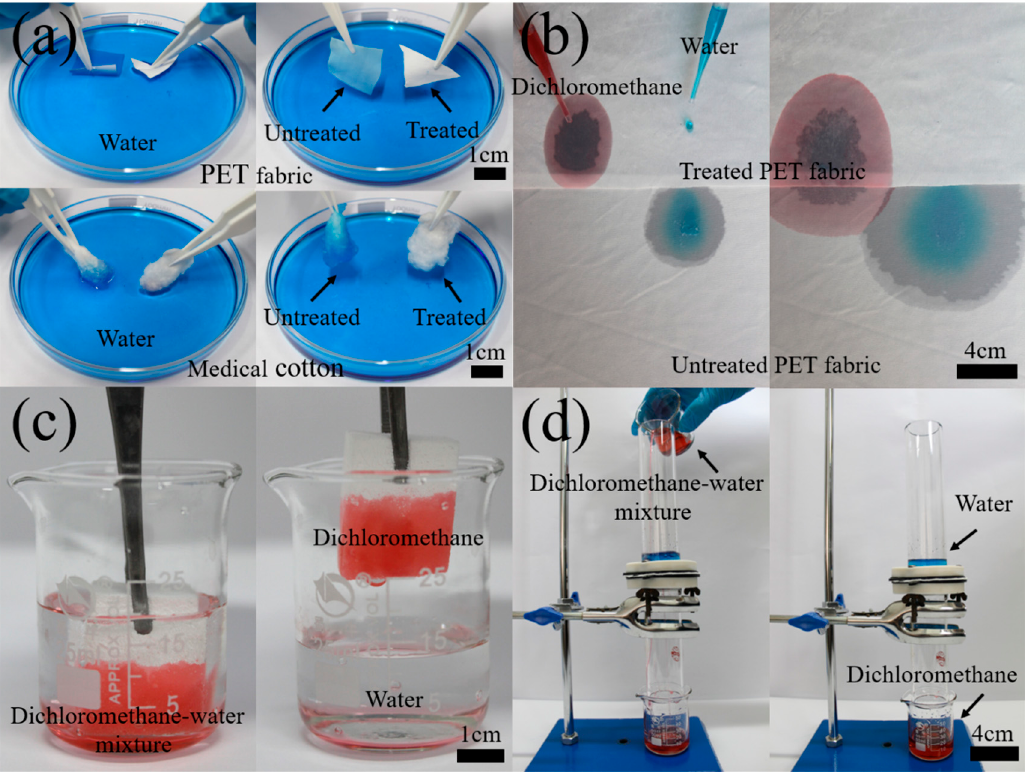
Figure 8. Applications of the superhydrophobic coating. ( a ) Comparison of water-repellent ability of the treated (left) and untreated (right) PET fabric and medical cotton. ( b ) Comparison of the super-wettability of treated (top) and untreated PET fabric (bottom) for dichloromethane (dyed red) and water (dyed blue). ( c ) Treated PU foam absorbing dichloromethane (dyed red) only in dichloromethane–water mixture. ( d ) Gravity-driven separation of dichloromethane (dyed red)–water (dyed blue) mixture by the treated PP filter cloth.